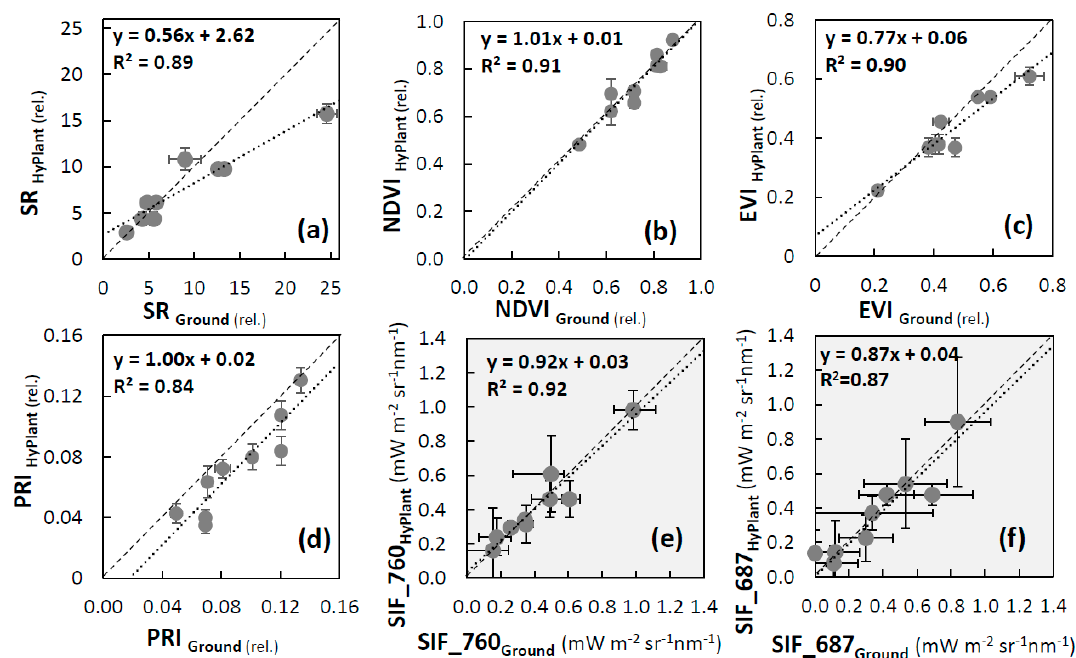
Figure 5. Validation of airborne HyPlant - derived VIs and SIF with ground observations on corresponding plots; ( a ) SR, ( b ) NDVI, ( c ) EVI, ( d ) PRI, ( e ) SIF at 760 nm, and ( f ) SIF at 687 nm. Error bars represent the spatial variability of the index values within the selected plots during HyPlant overpasses. Note: HyPlant SIF values were retrieved from the rescaled data (for details see Section 2.6.